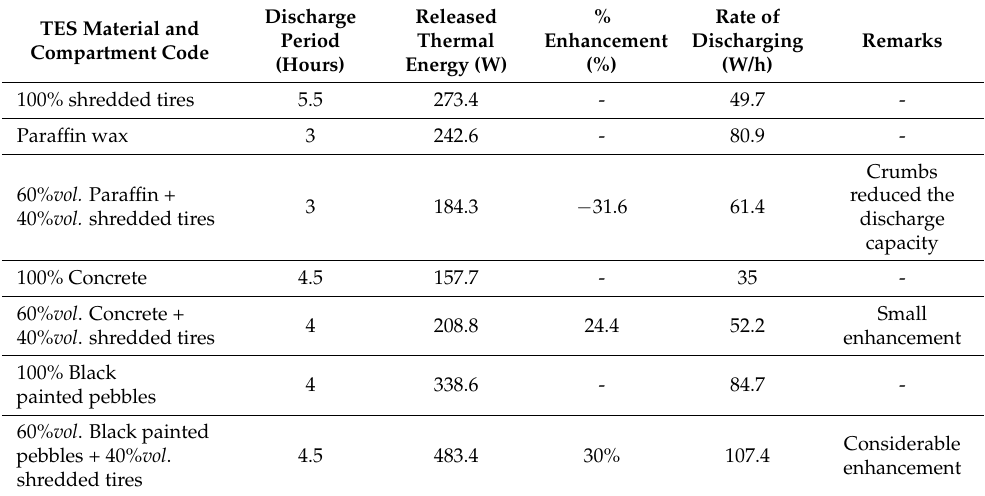
Table 6. Discharging behaviors of the tested TES materials with and without 40% vol added shredded